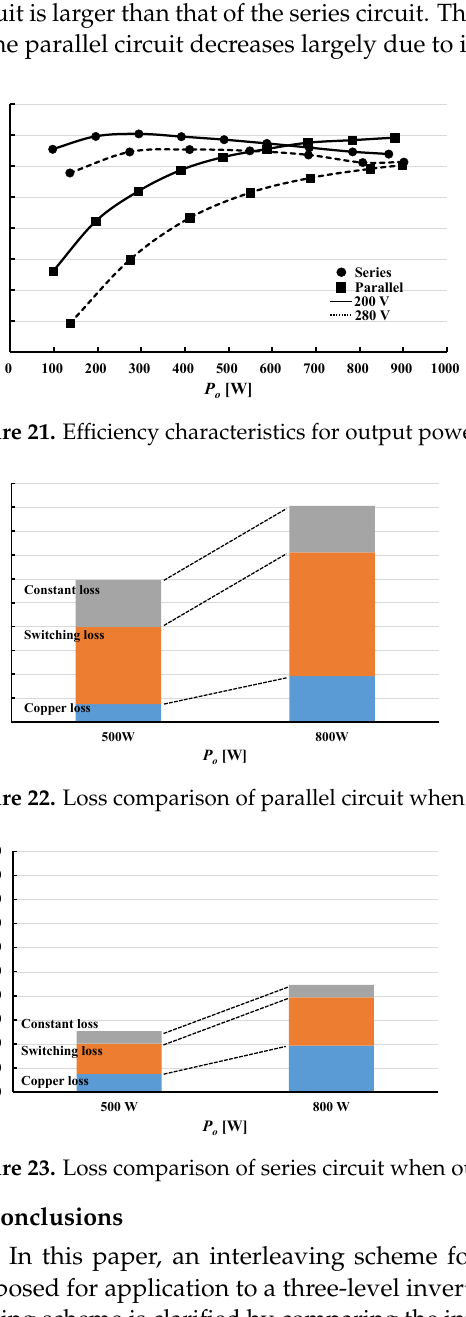
Figure 20. Efficiency characteristics for output voltage.